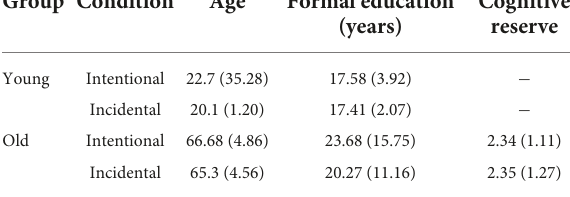
TABLE 1 Socio-demographic information extracted from the LEAP-Q